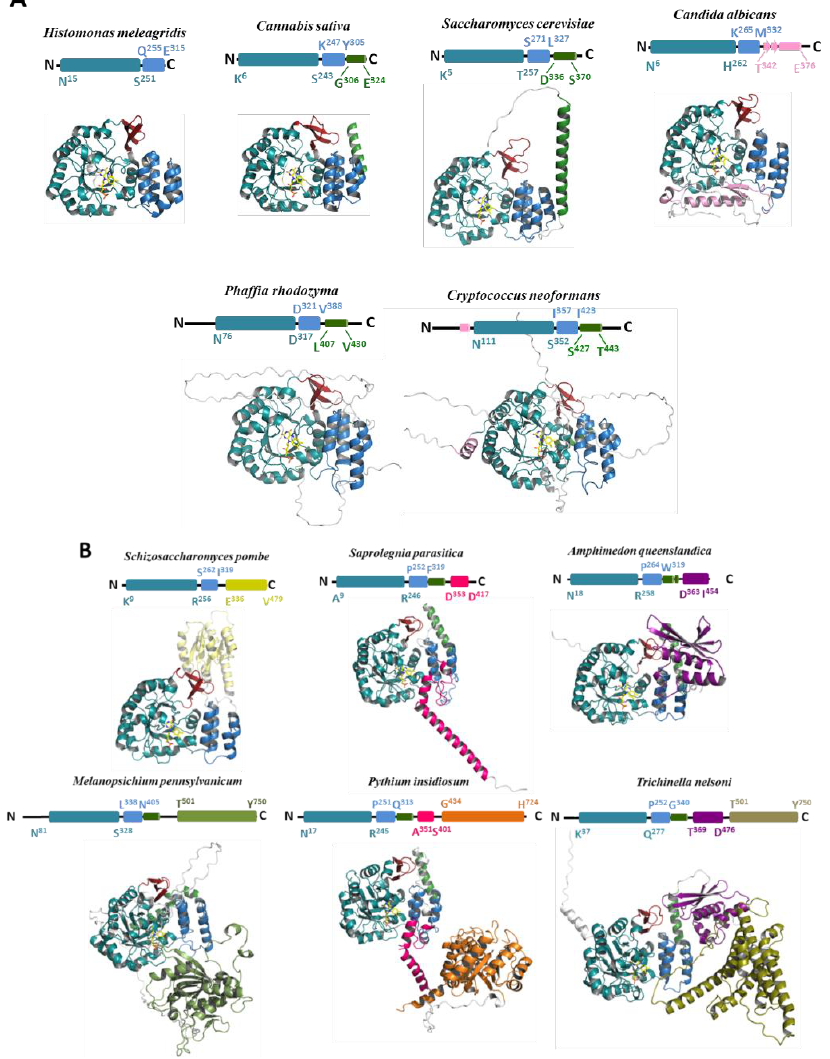
Figure 4. 3D structural models of various Dus2. ( A ) Models of Dus2 showing minimal modularity. The TIM-barrel domain (TBD) appears in teal, while the inserted beta-sheet is in red, the helical domain (HD) is in blue, the connective alpha-helix (c- α H) is in green, and the other structural extensions are in pink. The FMN coenzyme is denoted in yellow. ( B ) Models of Dus2 showing complex modularity with the addition of an extra domain. The same color codes for the canonical domains are followed (TBD + inserted beta sheet + HD). Rossman, zinc finger, dsRBD, PyrOX_2, ICL_KPHMT, and CTNS domains are in yellow, pink, purple, light green, orange, and olive, respectively. Above each of model is represented the schematic modular organization of Dus2 and is indicated the boundary of each domain. We have chosen not to show the delineation of the inserted beta-sheet in order to avoid figure overload. However, this structural element is colored in red in each of the 3D models presented.